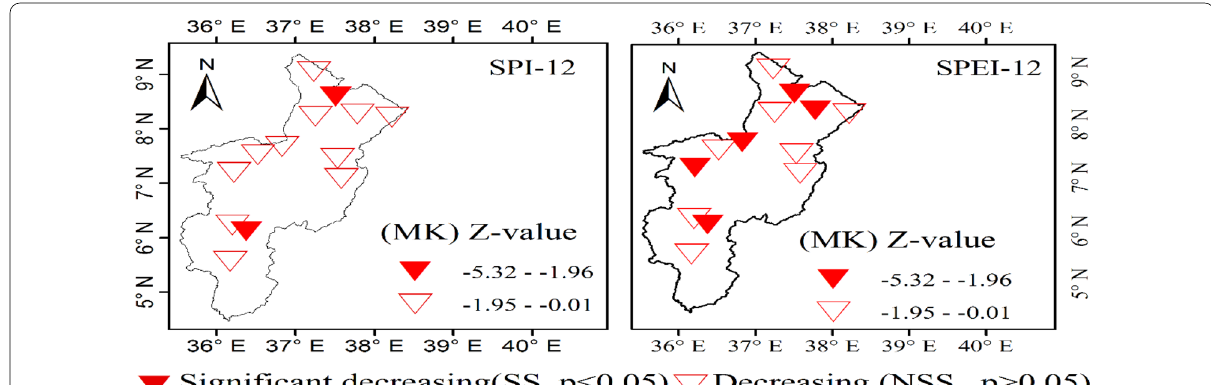
Fig. 7 Spatial patterns of the changing trend of seasonal drought severity based on the SPI-12 and SPEI-12 time-series detected by the Mann– Kendall trend test. The solid downward red triangle denotes the increasing dryness trend Statistically Significant (SS) at the 95% confidence level. The red hallow downward triangle denotes Not-Significant (NS) increasing dryness